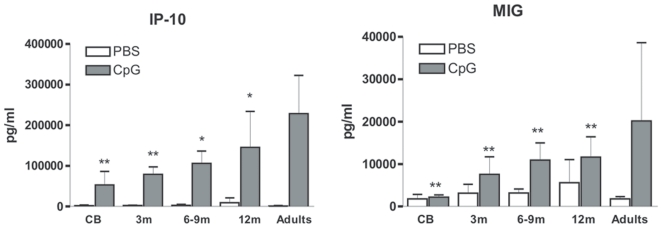
Age-dependent upregulation of CpG-induced production of IP-10 and MIG.Whole blood samples were stimulated with CpG A+B combination and culture supernatants were collected after 16–18 h. Production in the different infant groups was compared to adult values. Cord blood (CB, n = 13), 3-month (3 m, n = 10), 6&9-month (6 m, n = 3, 9 m, n = 5), 12-month (12 m, n = 11) old infants and healthy adults (n = 10). Data are represented as median+interquartile range. *p<0.05, **p<0.01, ***p<0.001 as compared to stimulated adult samples.